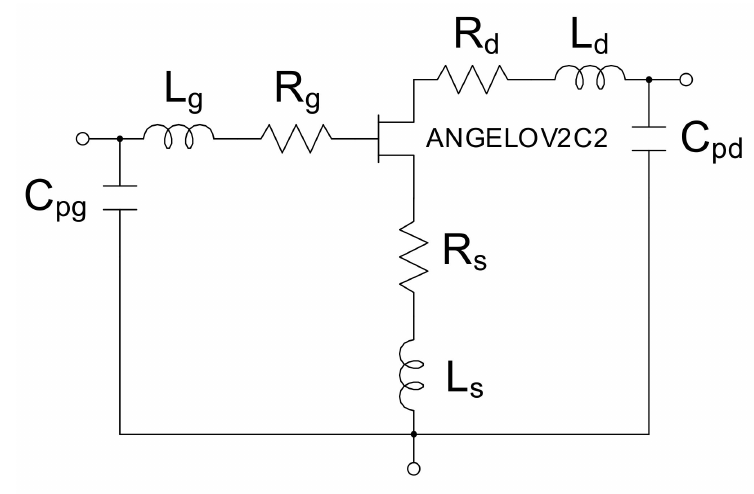
Figure 5. Equivalent circuit for a nonlinear model of GaAs pHEMT. The measured and simulated small-signal S-parameters and 50-ohm noise figures for a 4 × 50 µ m transistor are shown in Figure 6.